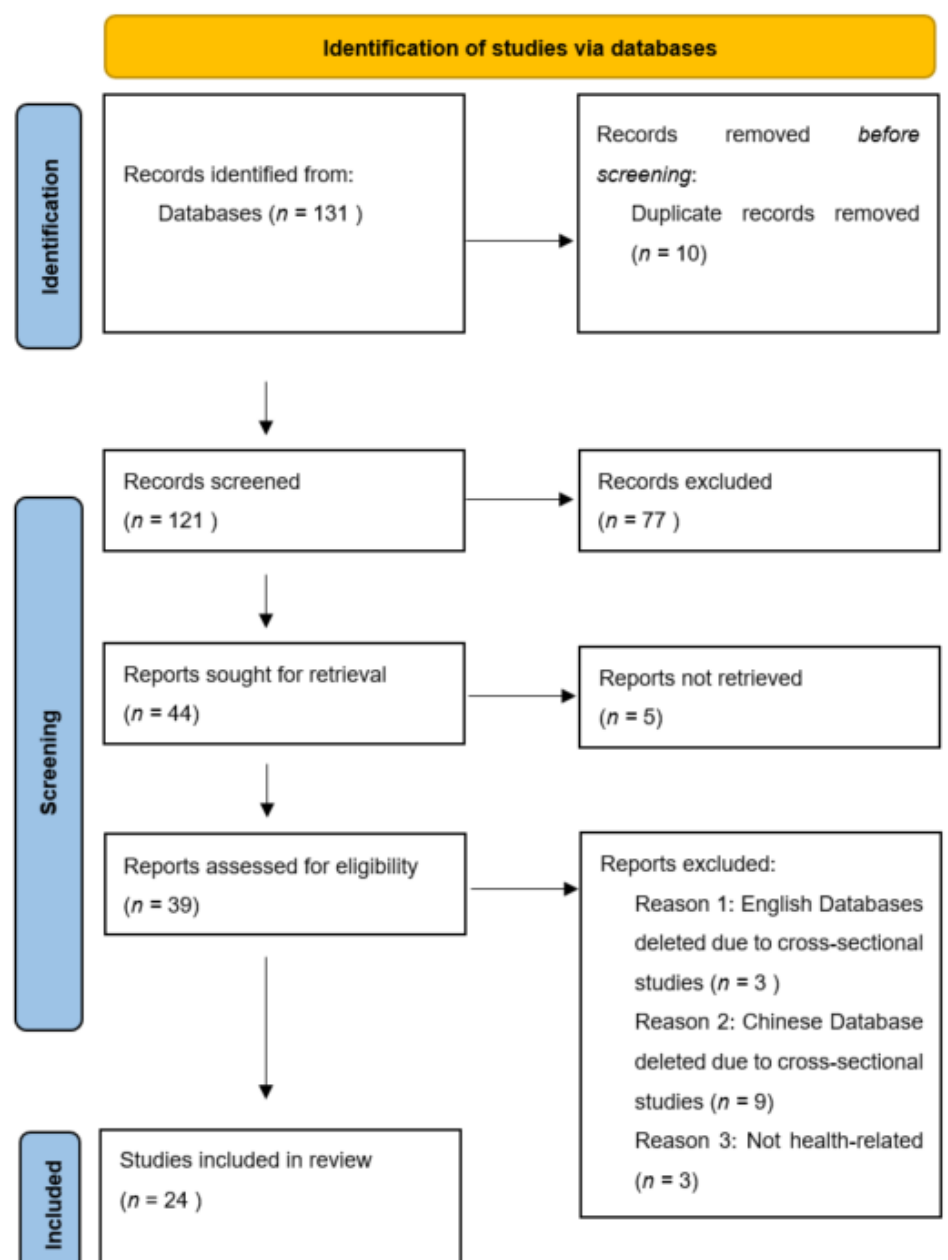
Figure 1. The PRISMA flow diagram.